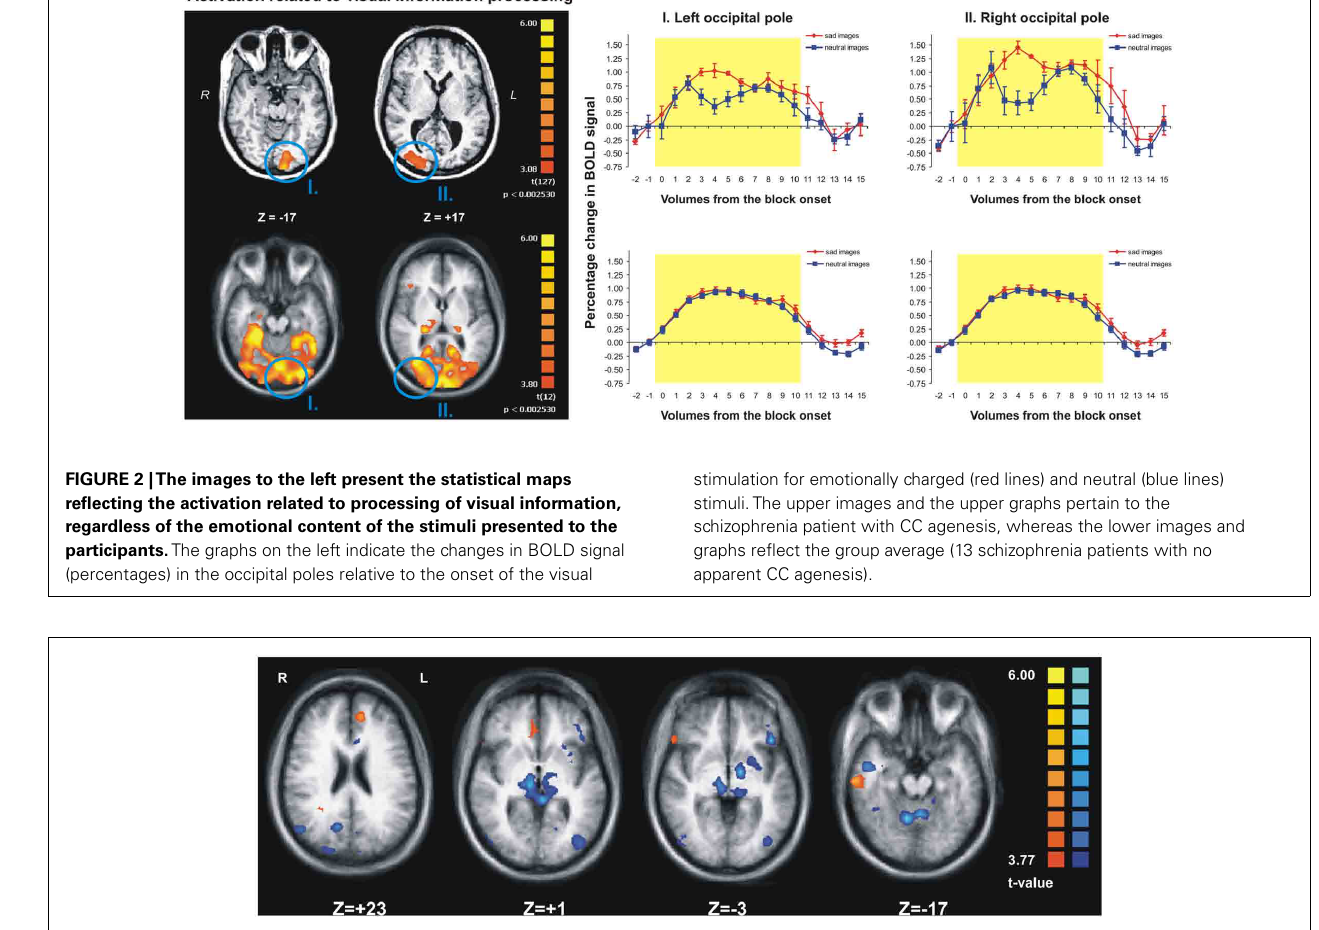
CC agenesis, whereas the blue clusters correspond to the activation at the group level for the 13 schizophrenia patients with no apparent CC agenesis (CC